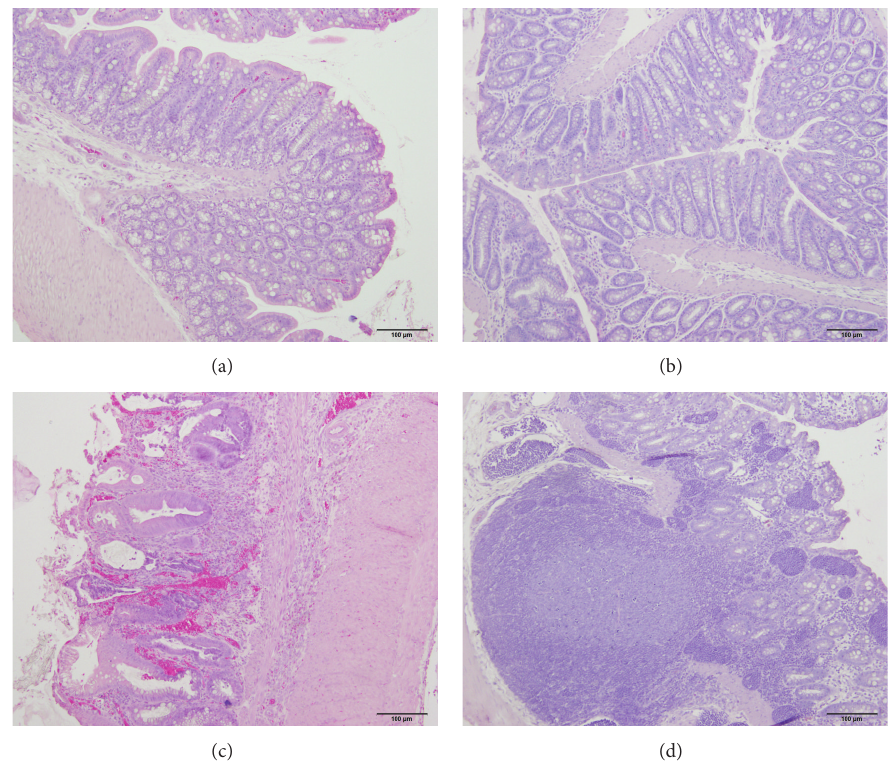
Figure 7: Photomicrographs of the colons of control rats ((a) and (b)), a rat treated with DTCM-G (c), and a rat treated with DHMEQ